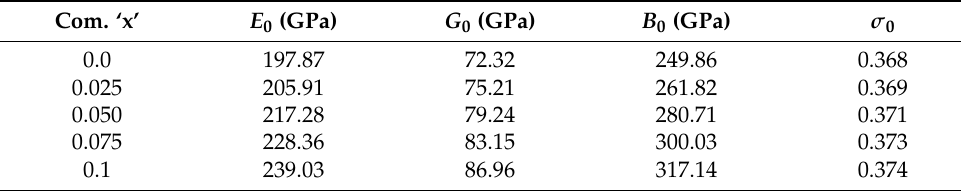
Table 5. Pore free elastic properties of CoCr 0.5 Dy x Fe 1.5-x O 4 .